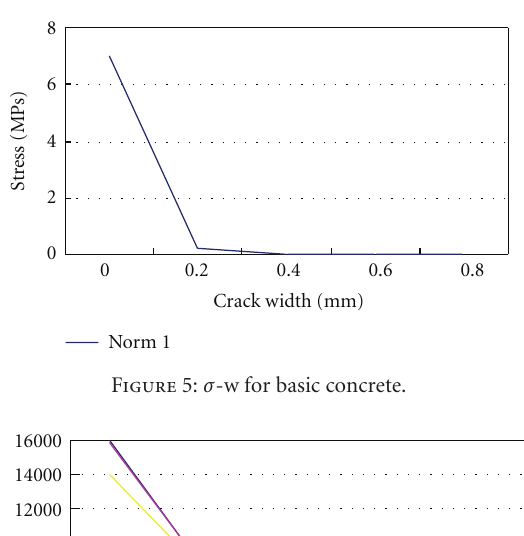
Figure 1: Damaged C120 concrete.